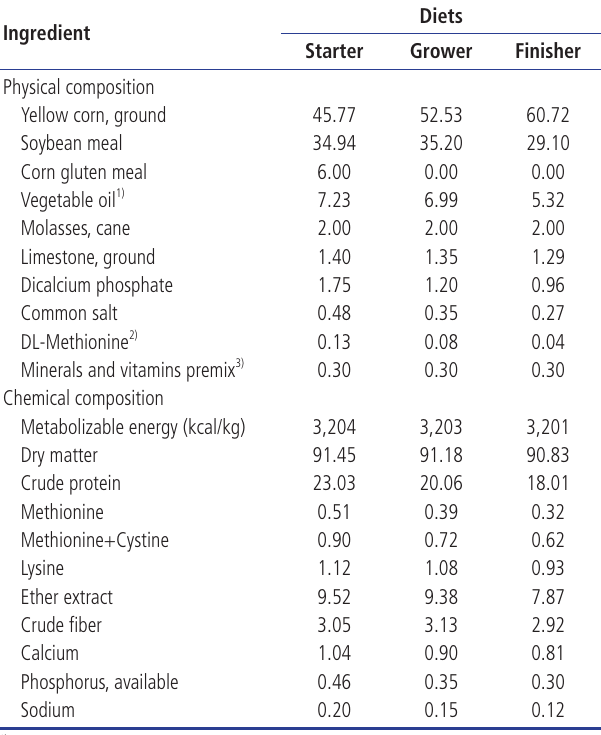
Diets Starter Grower Finisher